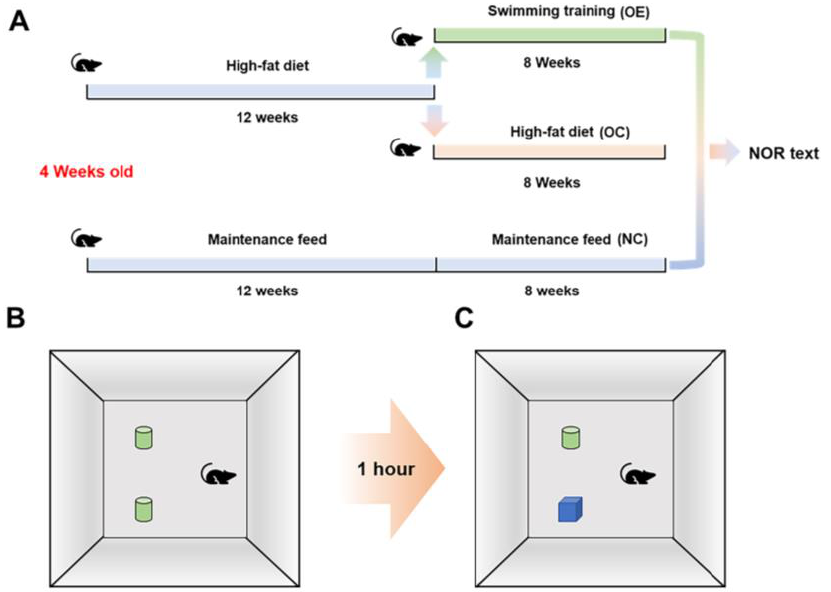
Figure 1. The diagram for describing animal grouping with corresponding feeding and exercise intervention, as well as new object recognition test. ( A ) Flow chart of mouse grouping with corre- sponding feeding and exercise intervention; ( B ) A 10-min test environment adaptation; ( C ) learning and memory capacity test.